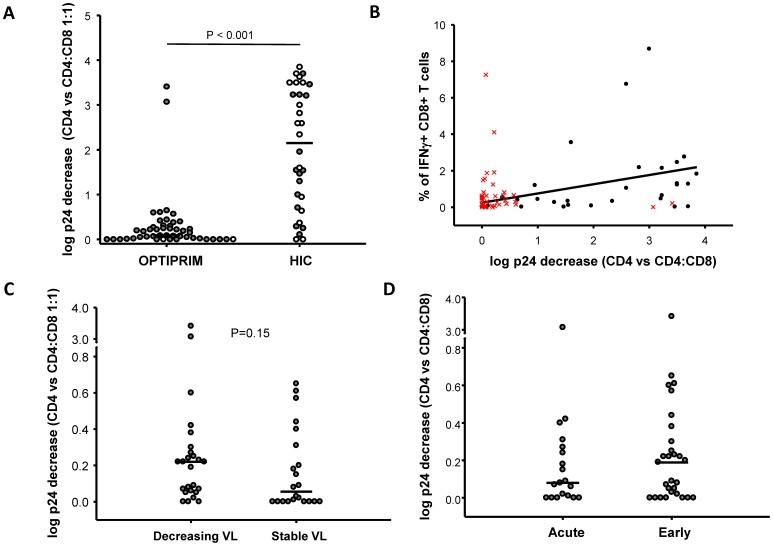
Modest capacity of CD8+ T cells from PHI-patients to suppress infection.
A. Capacity of CD8+ T-cells from PHI patients and HIC to suppress HIV infection of autologous CD4+ T-cells ex vivo, measured as the log fall in p24 production in culture supernatants when CD4+ T-cells superinfected in vitro with HIV-1 Bal were co-cultured with unstimulated autologous CD8+ T-cells at a ratio of 1∶1, by comparison with p24 production by superinfected CD4+ T-cells cultured alone. Each symbol represents one patient. Open circles represent patients carrying at least one HLA-B*27 or B*57 allele. B. Correlation between CD8+ T-cell-mediated HIV suppression and the frequency of IFNγ-producing CD8+ T-cells between HIC (black symbols) and PHI patients (red symbols). Linear regression is shown for HIC. C. Capacity of CD8+ T-cells from patients with acute or early PHI to suppress HIV infection ex vivo. D. Comparison of the capacity of CD8+ T-cells from PHI patients with decreasing and stable viral loads to suppress HIV infection of autologous CD4+ T-cells.